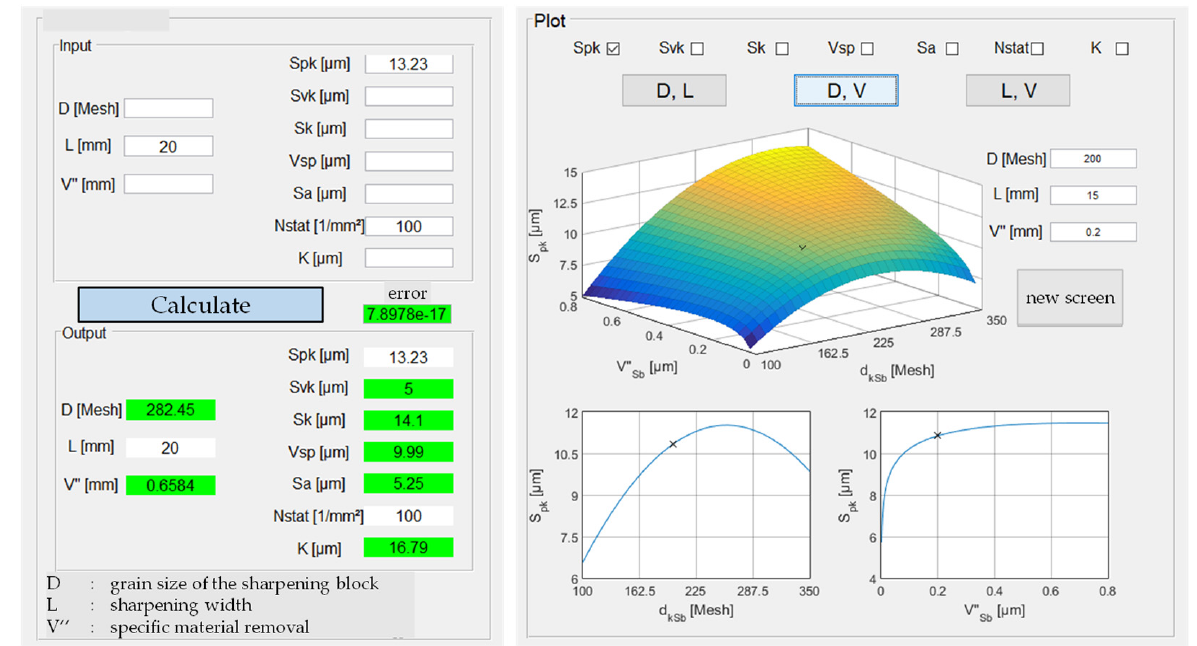
Figure 16. Graphical user interface of the process model.